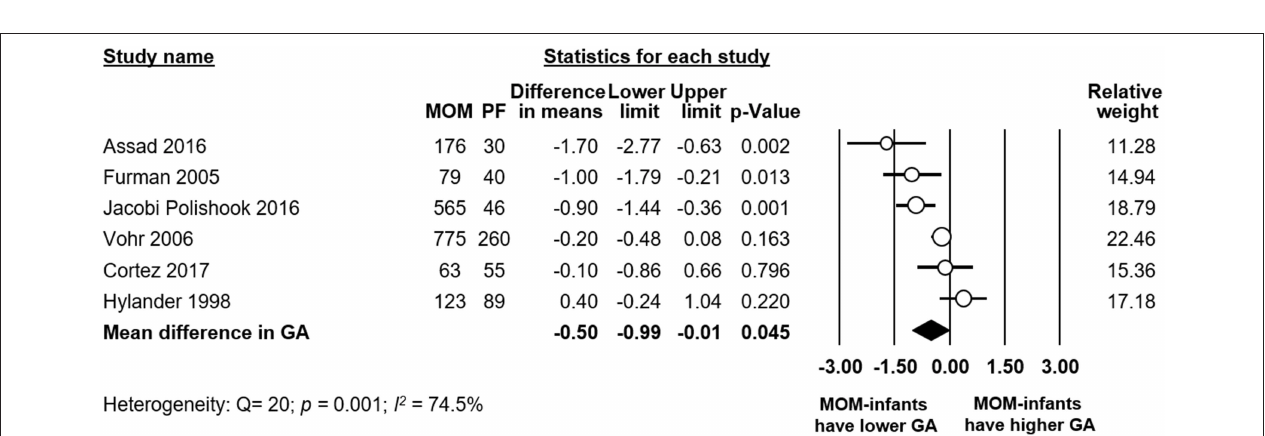
FIGURE 6 | Meta-analysis of Any MOM vs. Exclusive PF and risk of BPD. MOM, mother’s own milk; PF, preterm formula; BPD, bronchopulmonary dysplasia; CI, confidence interval; MH, Mantel-Haenszel.